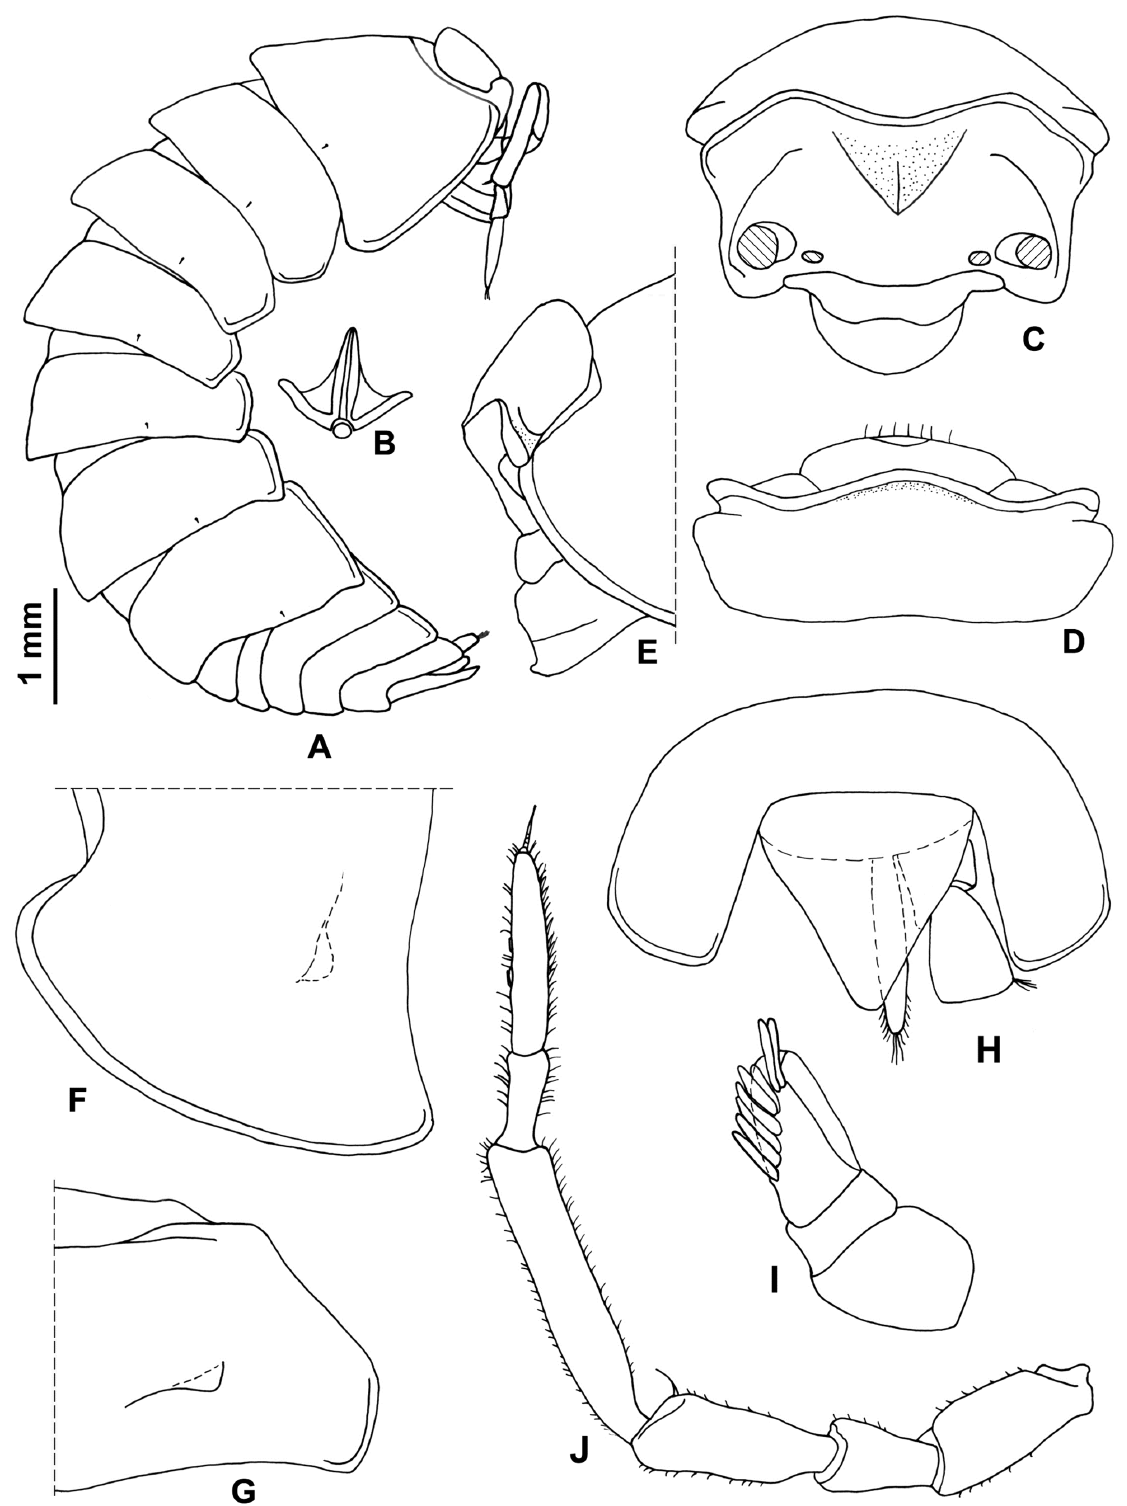
Fig. 33. Trogleluma machadoi (Vandel, 1946) from Algarão do Remexido, Algarve. — ♀. A . Specimen in lateral view. B . Scale-seta. — ♂. C . Cephalon in frontal view. D . Cephalon in dorsal view. E . Cephalon in lateral view. F . Epimeron of pereonite 1 in dorsal view. G . Epimeron of pereonite 2 in ventral view. H . Pleonite 5, telson and right uropod. I . Antennula. J .